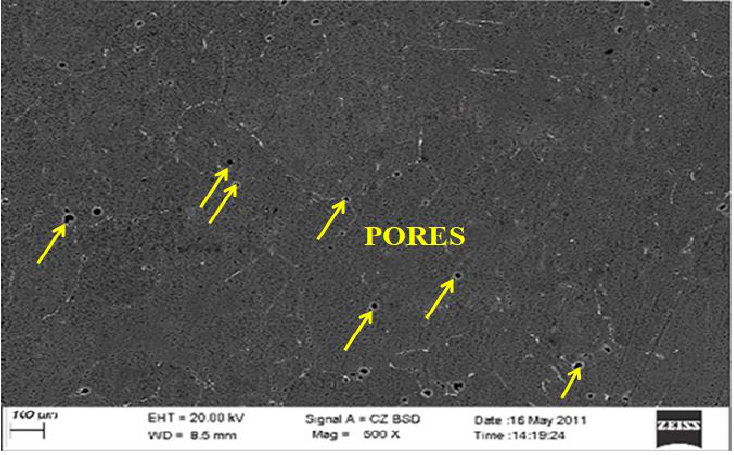
Figure 5. SEM image of traditionally cast